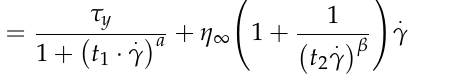
The flow curves were fitted using both the Cho–Cho–Jhon (CCJ) and Bingham equations [110].